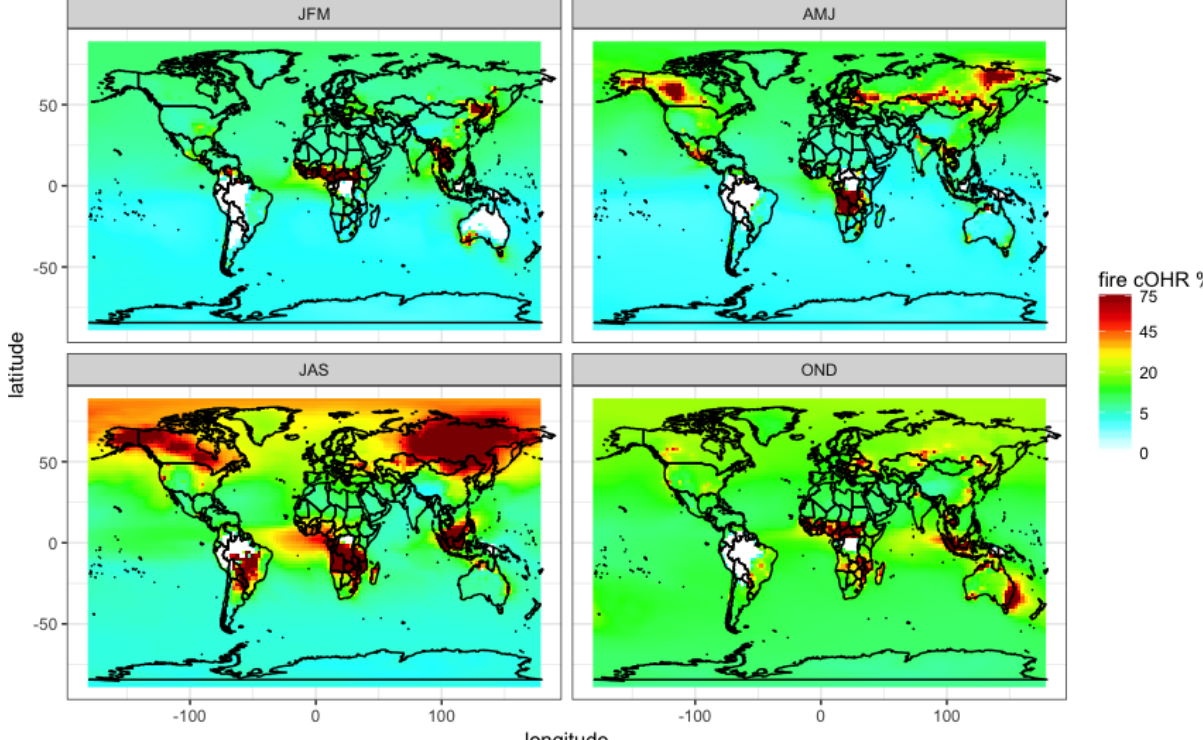
Figure 8. The percent of surface cOHR seasonally from fires in 2019 from the updated GEOS-Chem simulation (see Sect. 3) using GFED4s DM with Andreae (2019) emission factors. JFM is January, February, and March; AMJ is April, May, and June; JAS is July, August, and September; and OND is October, November, and